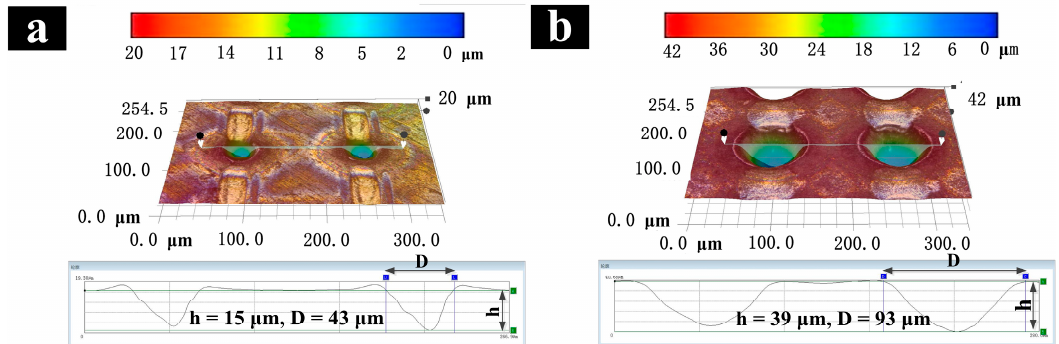
Figure 3. 2D and 3D morphology of micro-dimple array different Laser parameters: ( a ) Defocus amount L = 0.5 mm, Pulse number N = 40; ( b ) L = 2 mm, N = 100.